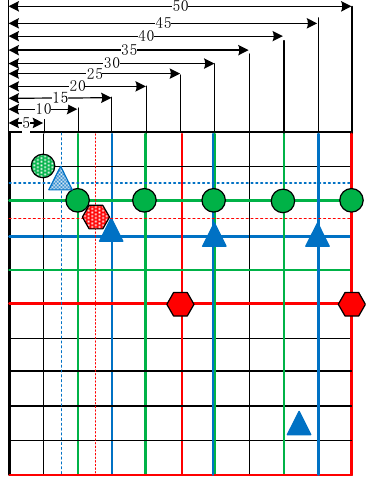
Figure 11. Initial grid size and subdivision.